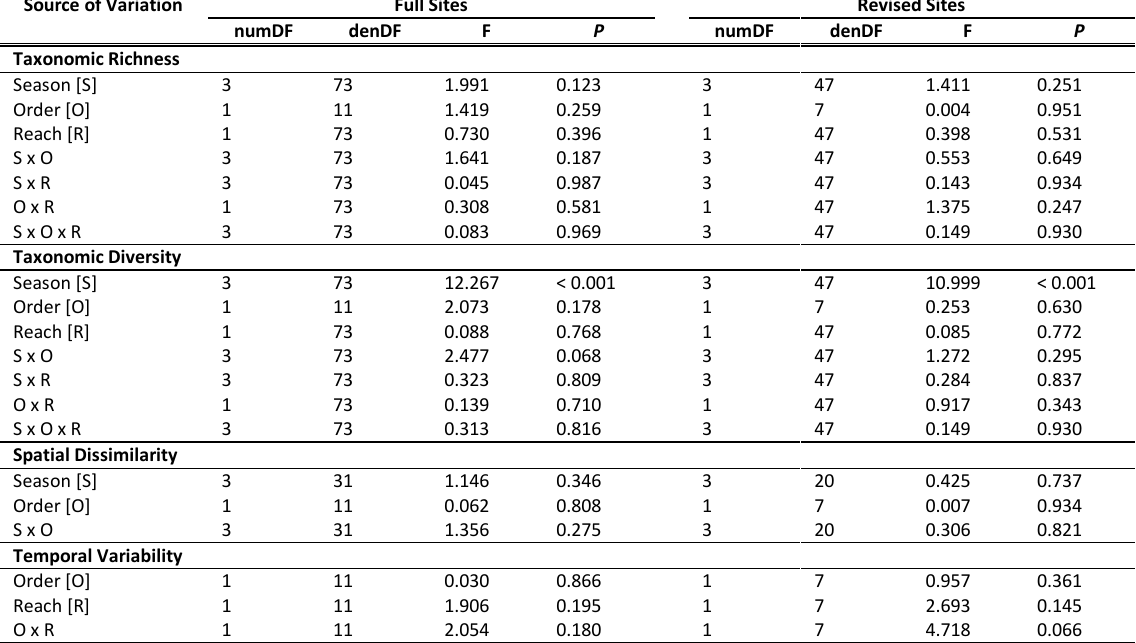
Table 2 : ANOVA results for taxonomic richness, taxonomic diversity, spatial dissimilarity, and temporal variability. Models were fitted using restricted maximum likelihood and with Type III sums-of-squares for estimating main and interactive effects of factors.